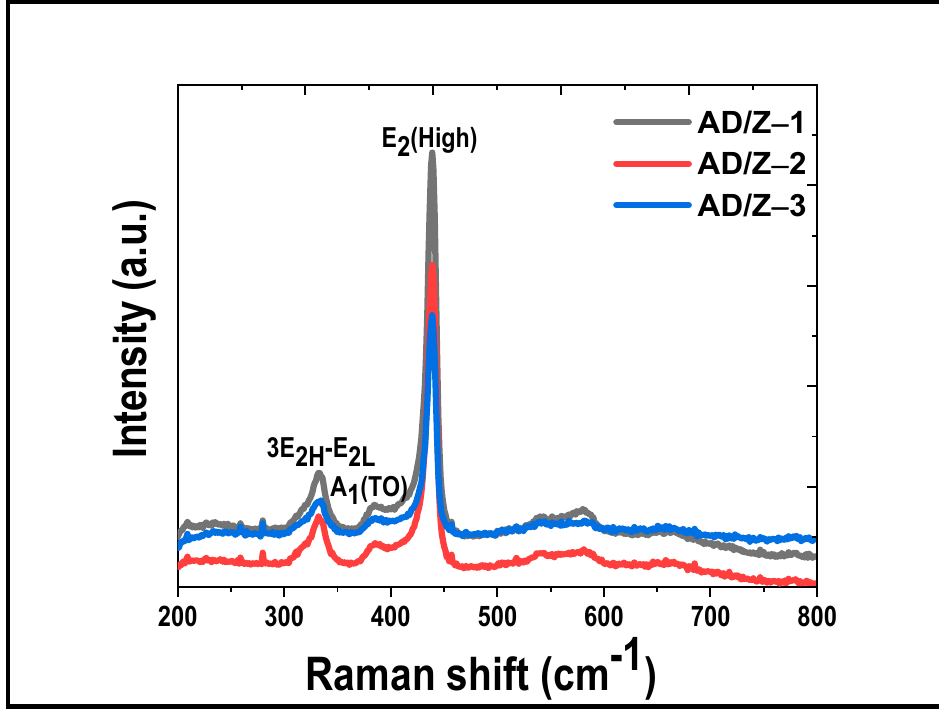
Figure 6. Raman spectra of the ZnO films deposited using the AD process.